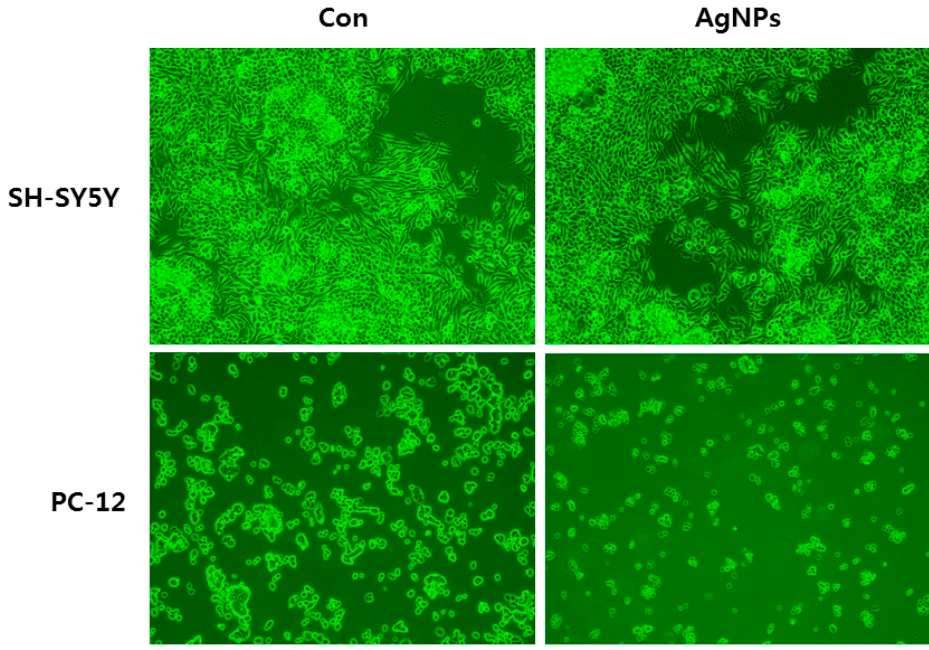
Figure 5. Effect of silver nanoparticles on cell morphology of human neuroblastoma SH-SY5Y cells and pheochromocytoma (PC-12) cells. The images were taken from cells with an average size of 40 nm treated for 24 h.